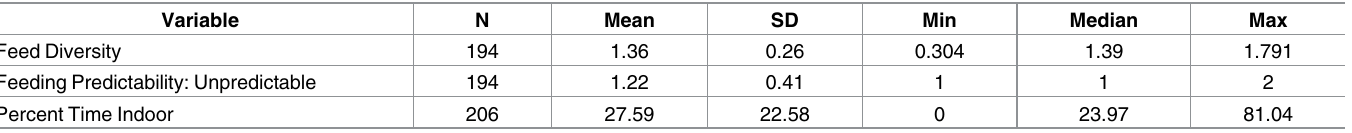
Table 14. Descriptivestatistics for variables in the G: I